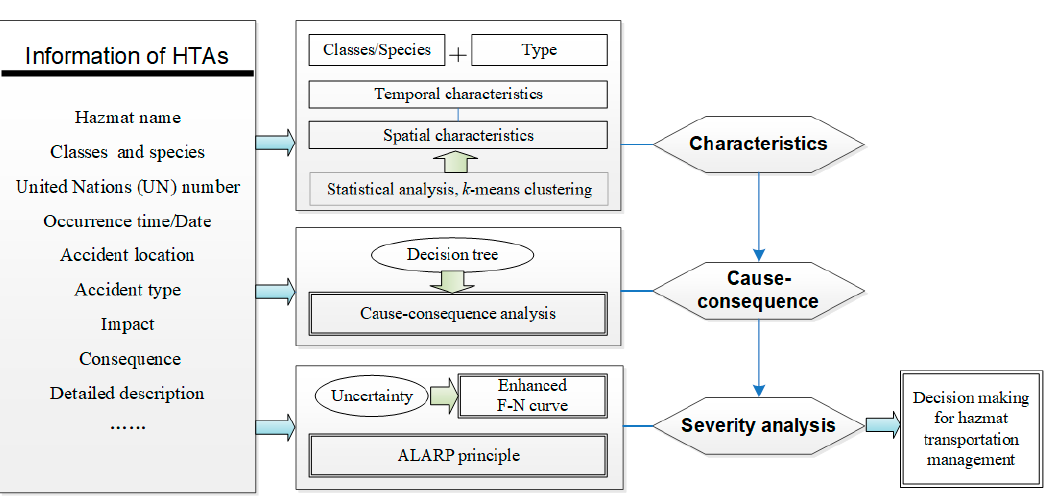
Figure 2. Study framework layout. In the figure, t he F-N curve describes the relationship between the cumulative probability F and the number of deaths N . T he ALARP principle is the abbreviation of as cumulative probability F and the number of deaths N . The ALARP principle is the abbreviation of as low as the reasonably practicable principle. low as the reasonably practicable